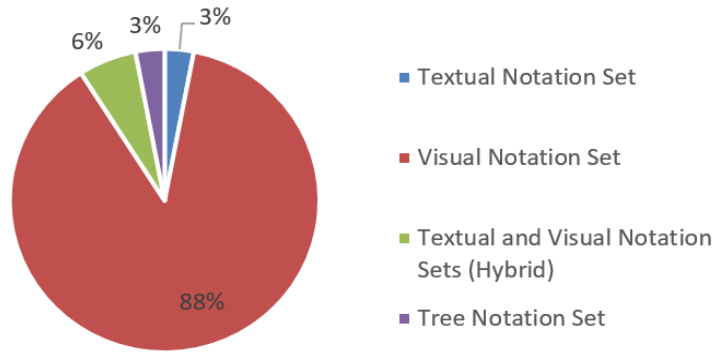
Figure 4. The percentages of the modeling languages for IoT that offer different types of notation sets.